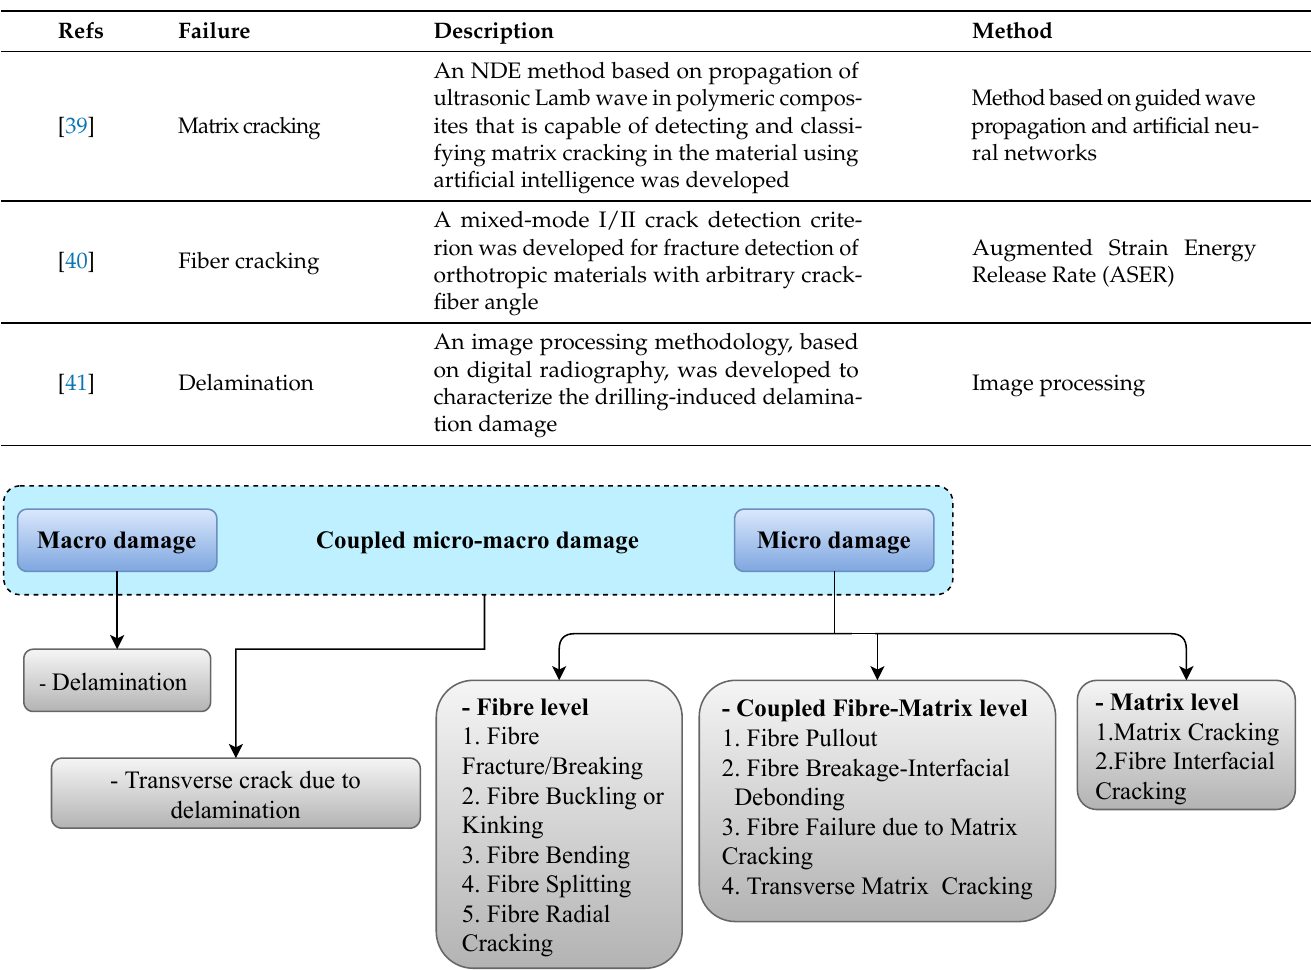
Table 2. Some common failure mechanisms along with recommended damage detection methods in composite structures.